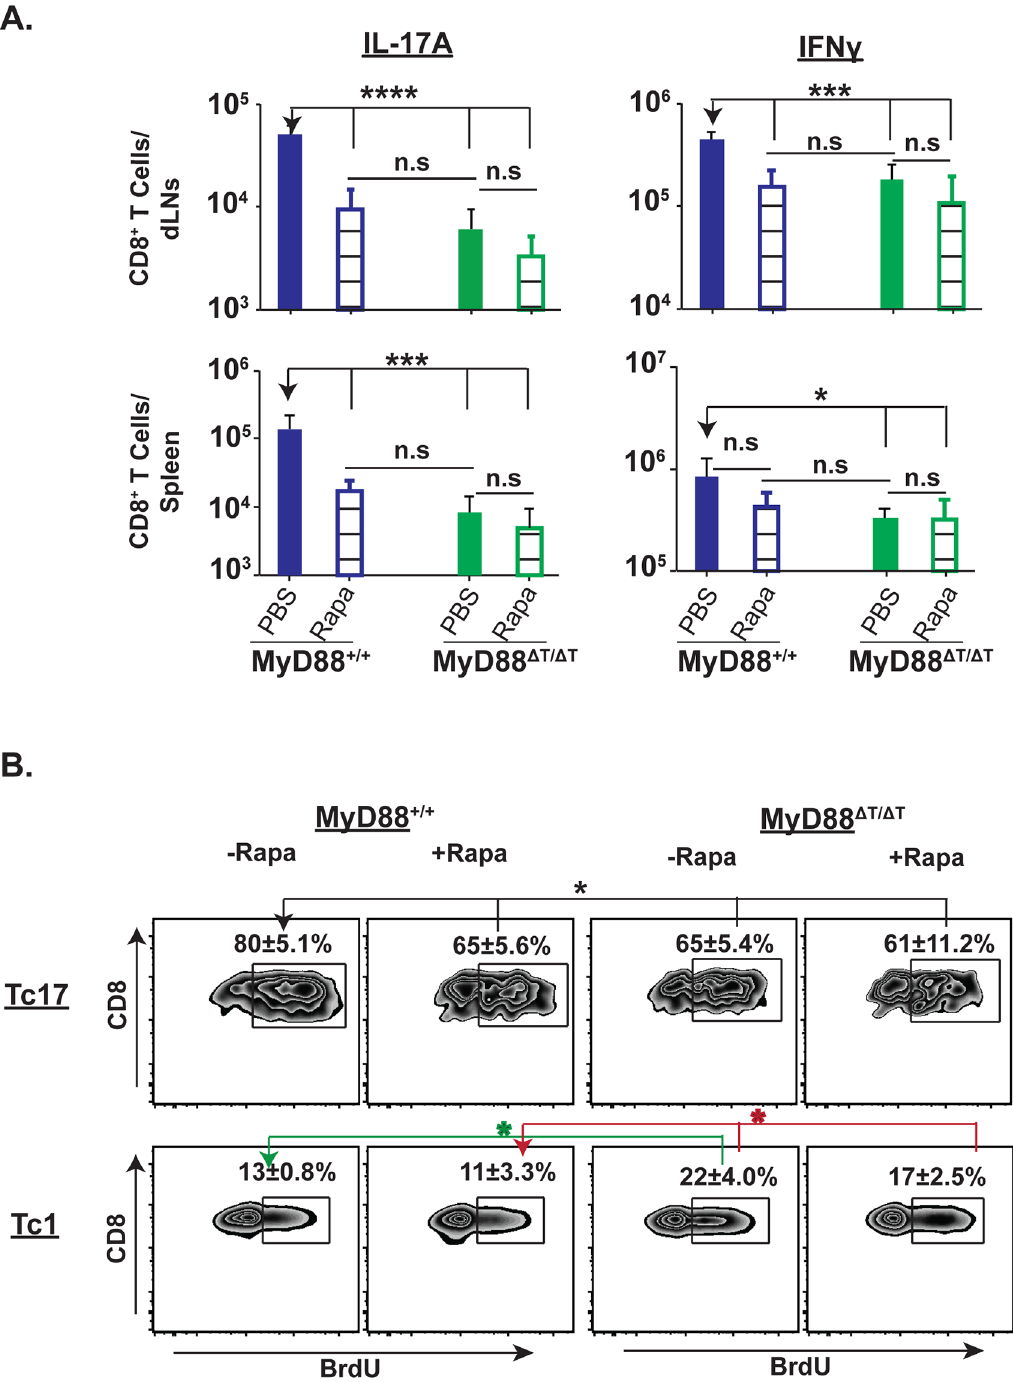
Fig 6. Rapamycin treatment blunts Tc17 cell responses and proliferation. Na ï ve WT and MyD88 Δ T mice were CD4 + T cell depleted and vaccinated with strain #55. Rapamycin (~2 μ g/mouse) was administered daily from day 4 by the i.p. route. On day 19 post-vaccination, dLNs and spleens were harvested to enumerate percent and total numbers of IL-17 and IFN γ producing CD8 + T cells (A) . Cohorts of mice were pulsed with BrdU through drinking water from day 7 – 15. On day 16, dLNs and spleens were harvested to enumerate percent BrdU +ve IL-17A and IFN γ producing CD8 + T cells (B) . Values are the mean ± SD of 4 – 7 mice/group. * p (cid:1) 0.05, *** p (cid:1) 0.001 and **** p (cid:1) 0.0001. Data is representative of 2 independent experiments.